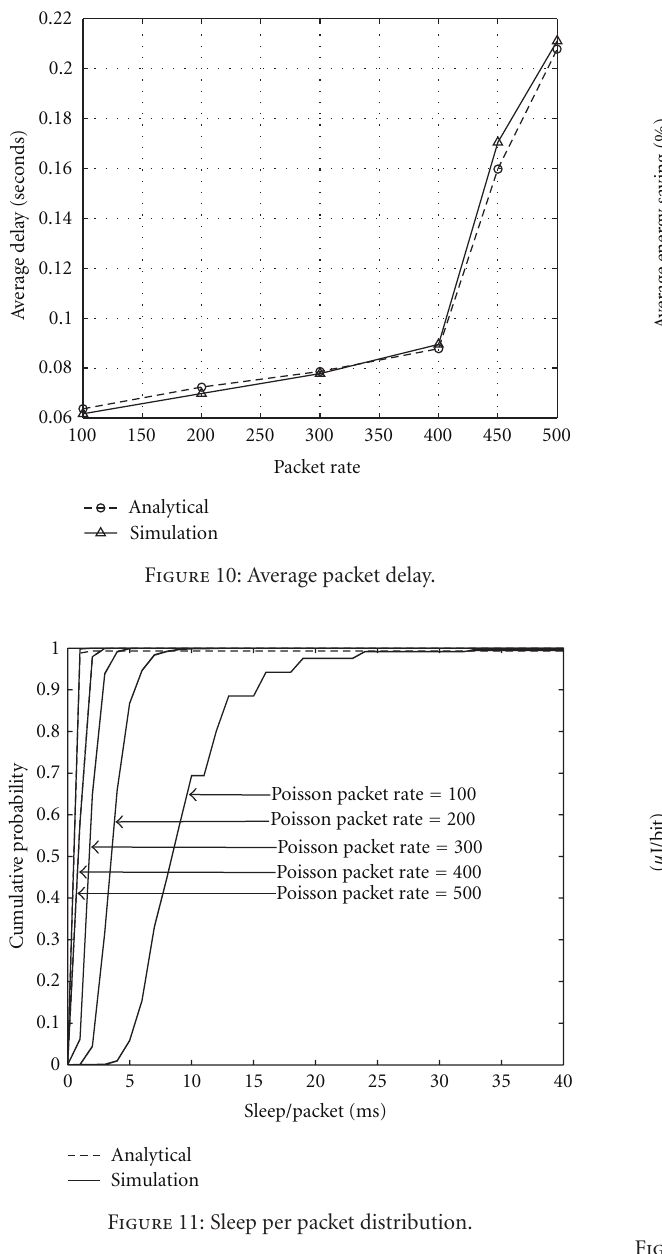
Figure 13: Energy consumption by the network in di ff erent power save mode for the